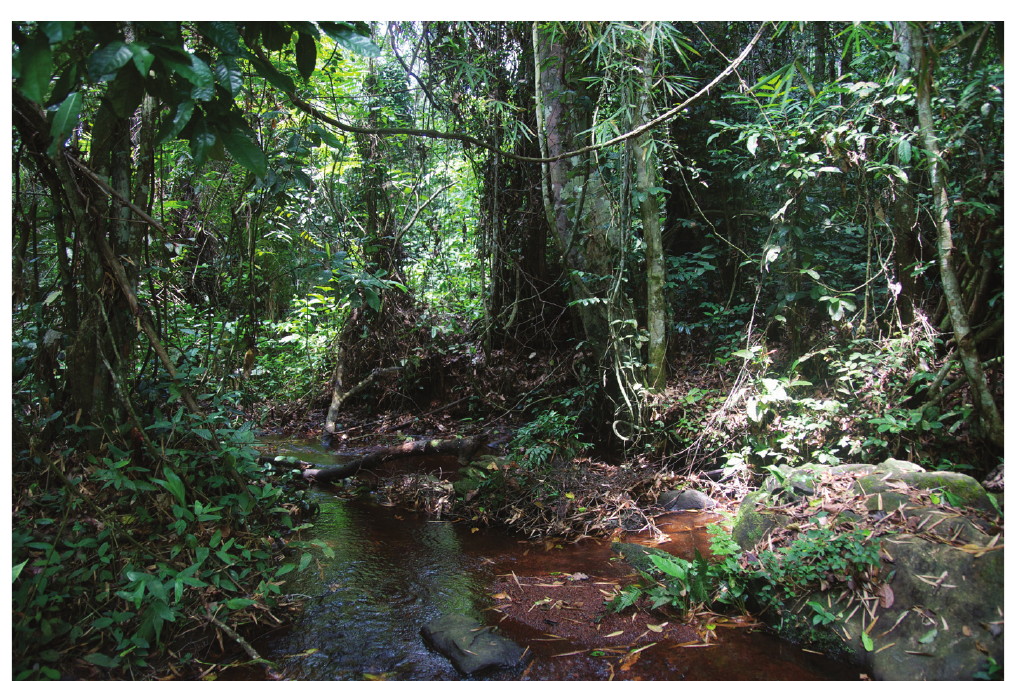
Fig. 3. Natural habitat of Thiratoscirtus oberleuthneri sp. nov. in Midzic, Gabon (photo by